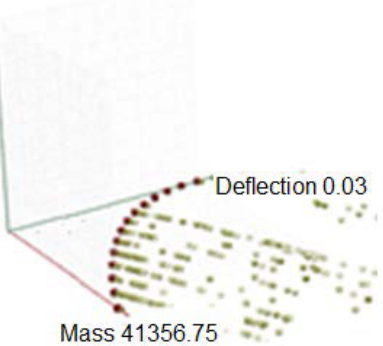
Figure 8. The 2D graph of the Pareto front for the hyperbolic paraboloid canopy structure with pattern b (split along long diagonal—division into four parts). Table 4. The results of the simulation assuming bar lengths within the scope of 1.0–3.0 m.